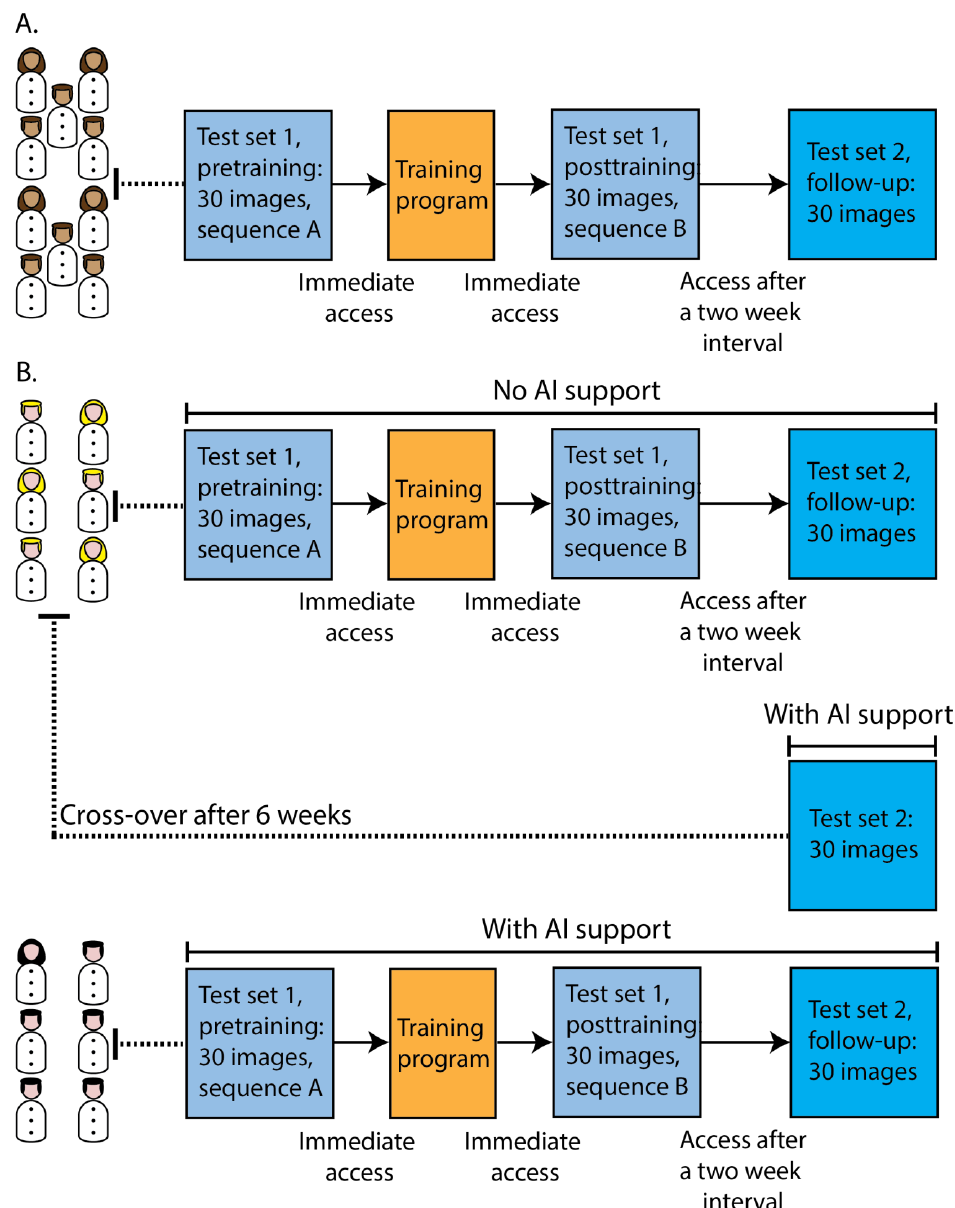
Figure 1. Schematic overview of the two cohorts participating in the online training and testing modules. ( A ) The first cohort of 10 endoscopists participated in the online training and testing modules during the pilot phase to validate the classification system. ( B ) A second cohort of 12 gastroenterologists participated in the same online training and testing modules: six unassisted gastroenterologists and six AI-assisted gastroenterologists. Lastly, a cross-over was performed in which the unassisted gastroenterologists were presented with Test Set 2 again, this time with AI assistance.